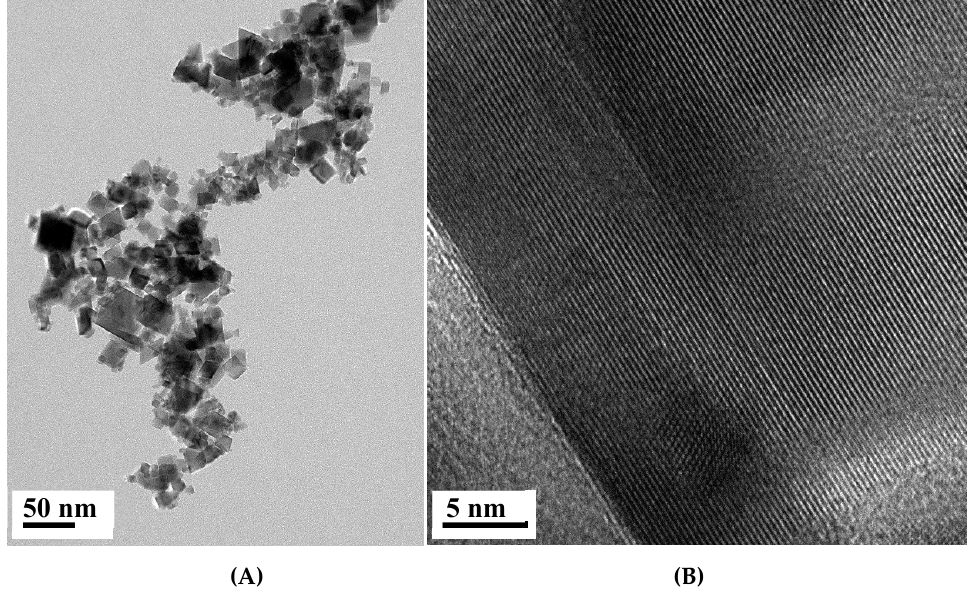
Figure 6. HRTEM image of CeO 2 NP ( A ) and a zoomed in detail ( B ).